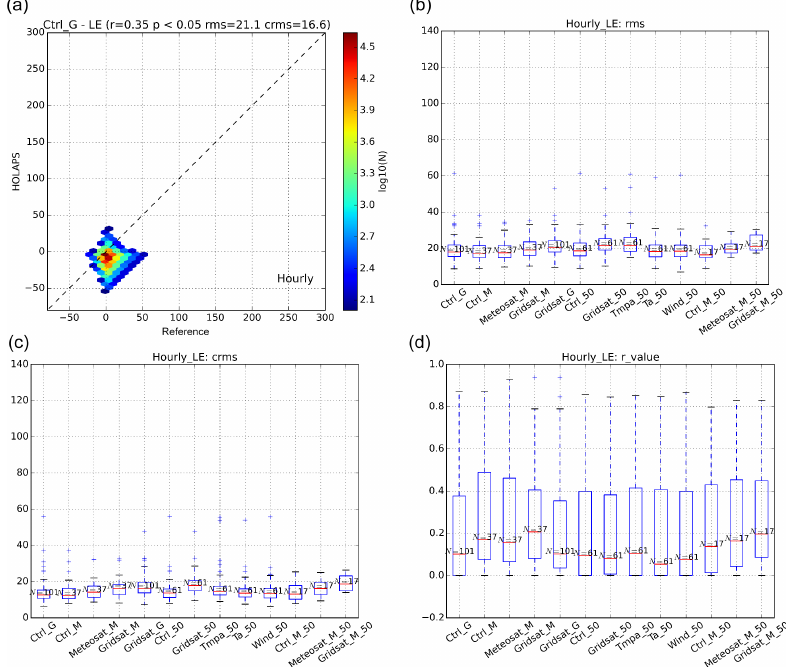
Figure E4. Error statistics for HOLAPS latent heat flux over nighttime: (a) comparison using results from all stations and years, (b – d) box plots of validation statistics that are calculated at each station.